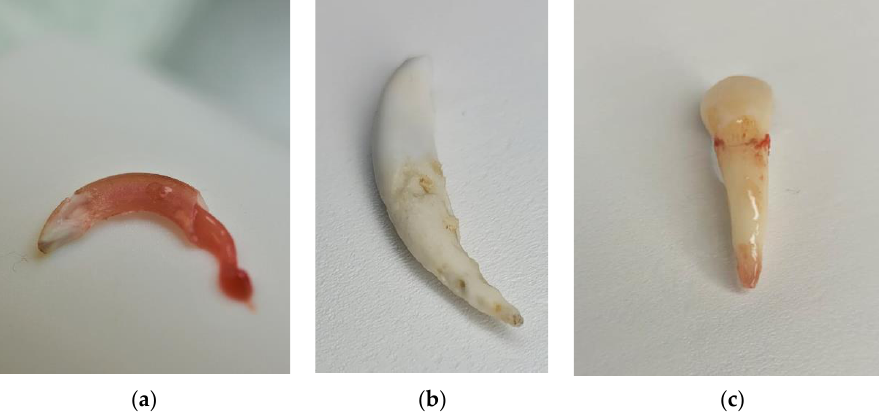
Figure 3. Rodent incisor with open top and living pulp ( a ). Comparison with thecodont and brachydont dog tooth ( b ) and human tooth ( c ) (by Małgorzata Peruga) .